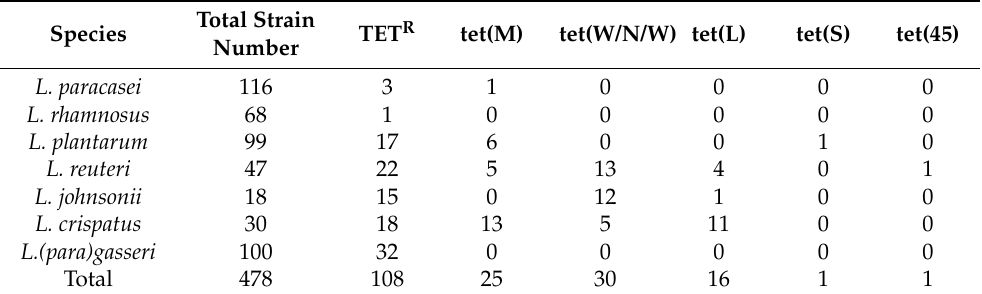
Table 3. The detailed distribution of the detected tetracycline resistance genes in different lactic acid bacterial